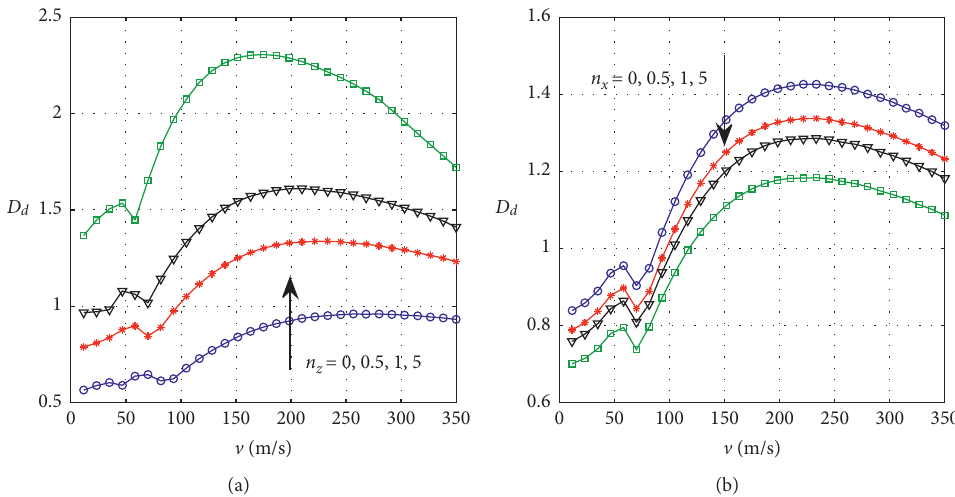
Figure 7: Variation of DMF with moving load speed of (2-2-1) beam. (a) n